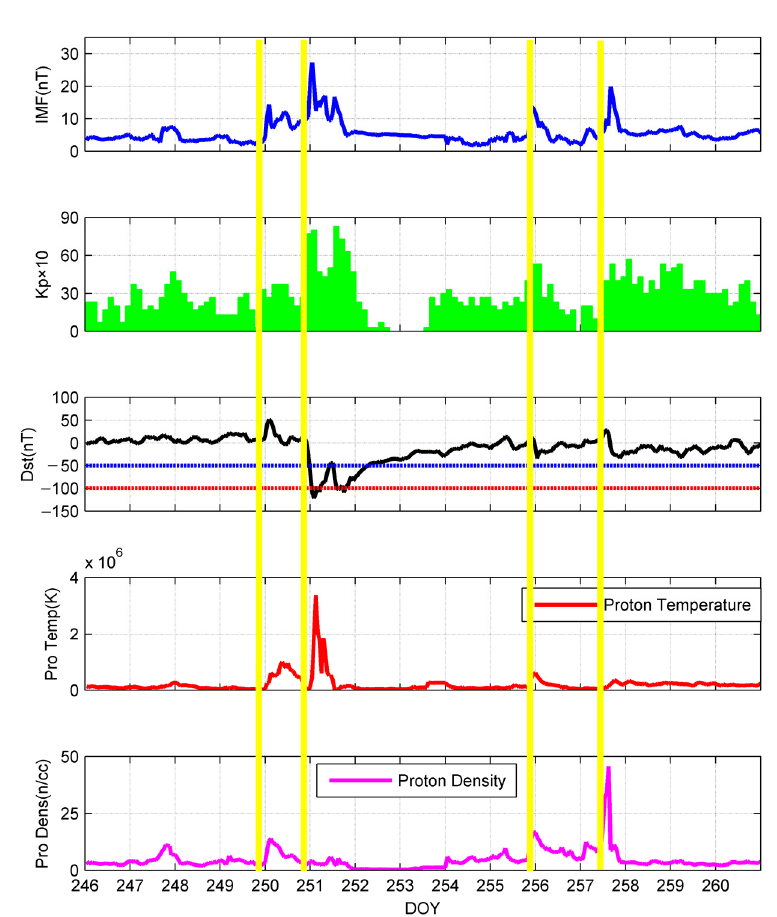
Figure 2. The space weather indices from 3 September 2017 (246th) to 17 September 2017 (260th). The blue solid line is the average IMF magnitude, unit: nT. The green histogram is the 10 xKp index. The black solid line is the Dst index, unit: nT, and the blue and red dashed lines represent the thresholds for moderate and strong storms, respectively. The red solid line represents the proton temperature, unit: K. The pink solid line represents the proton density, unit: n/cc. The above data is from SPDF: https://omniweb.gsfc.nasa.gov/form/dx1.html (accessed on 16 July 2022). In addition, the yellow solid lines represent sudden storm commencements (SSC, data sources: